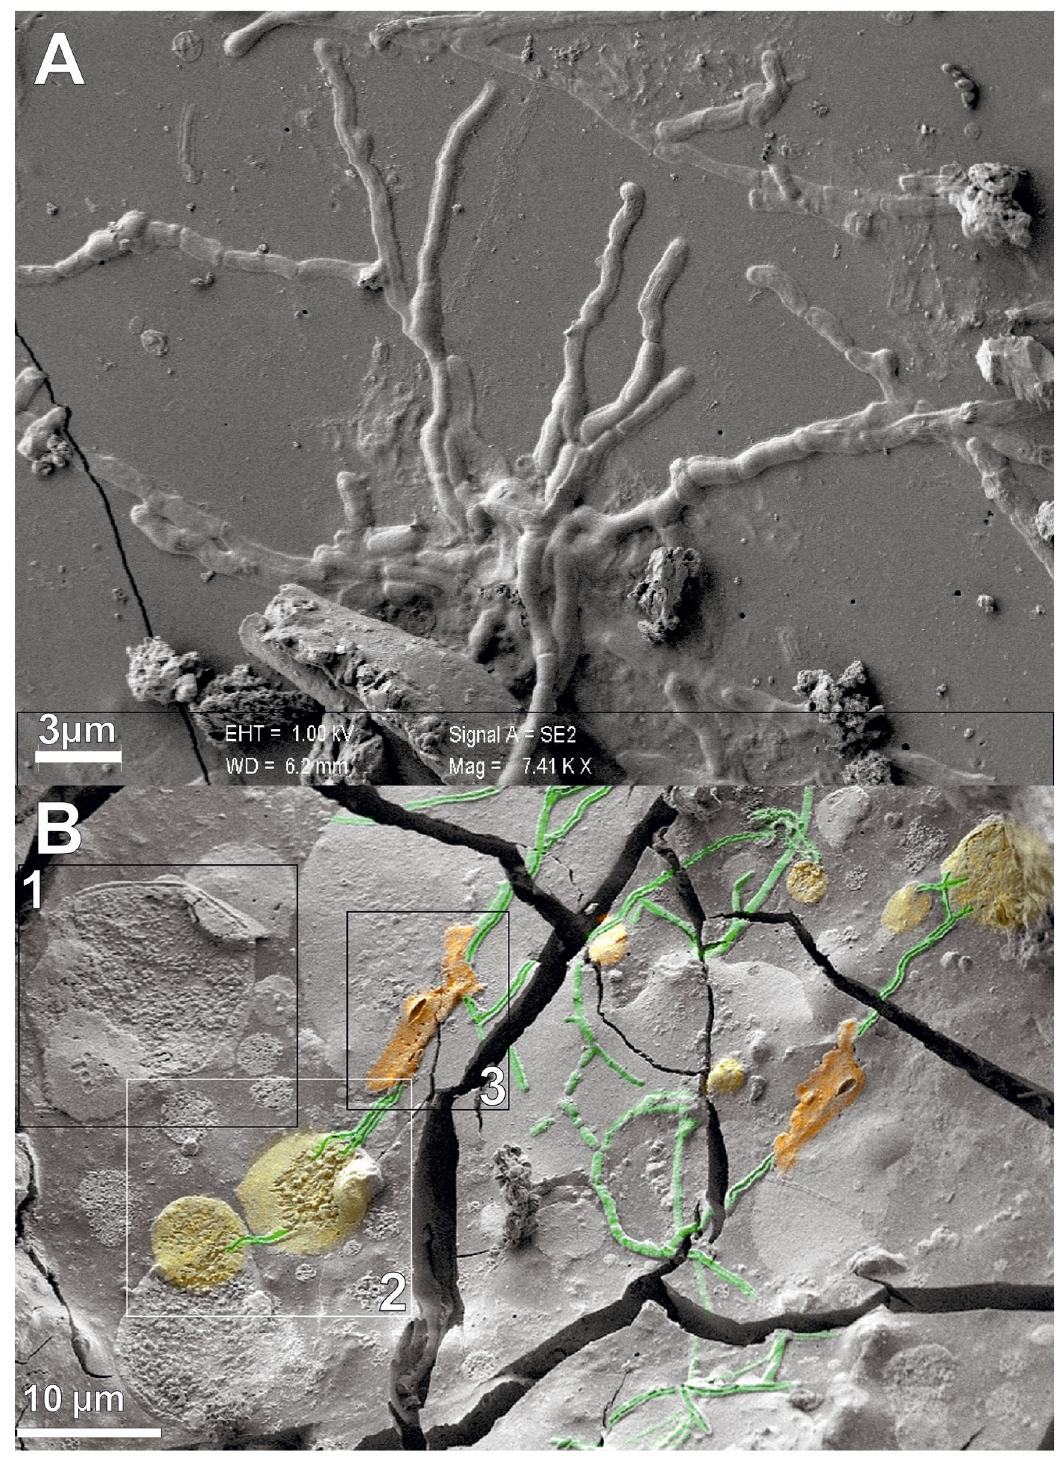
Fig 2. Structures of the central nervous system. A, SEM image of brain axons. B, SEM image of spinal cord axons (green) intercepting cell bodies and sheath-shaped structures (yellow and orange) (scale bars in micron).